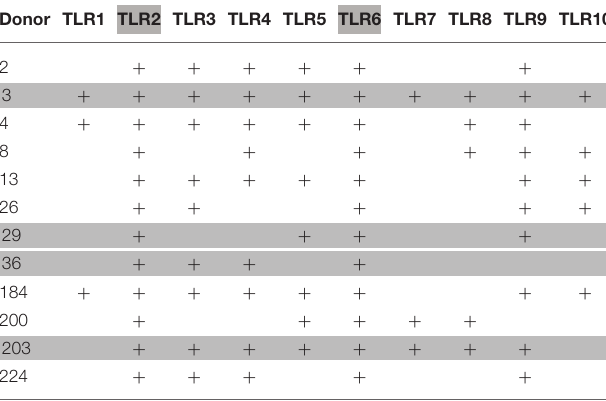
TABLE 2 | Individual TLR expression on human basophils as assessed by RT-PCR with TLR-specific